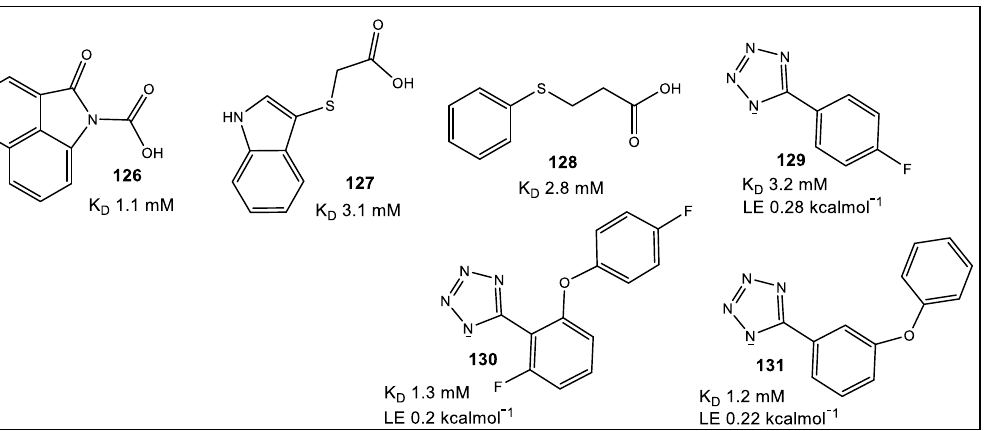
Figure 24. Hits chosen for further optimization based on the STD-NMR and their bind- 15 N –1 H HSQC NMR ing affinities (K D values; 15 N – 1 H HSQC NMR titration). (K D values;